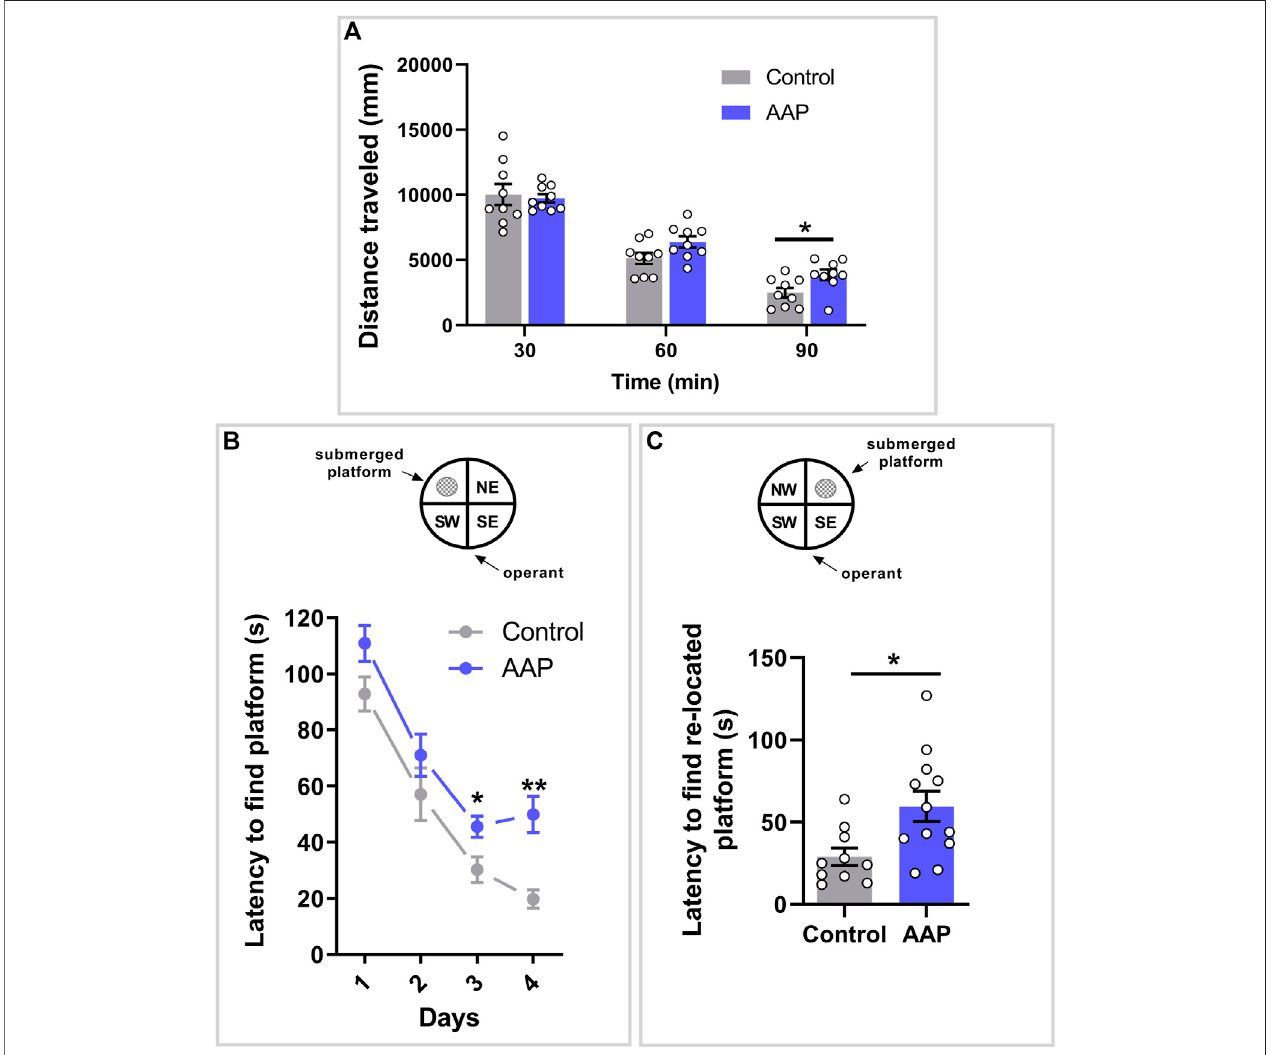
FIGURE 1 | Behavioral assessments in adulthood following neonatal exposure to AAP. (A) Spontaneous behavior in 3-month-old mice exposed to vehicle or AAP (30 + 30 mg/kg, 4 h apart) on PND 10. Distance traveled (mm) during each of the three time spells were measured when the mice were introduced to a new home cage ( n = 10). (B) Swim maze performance in four-month-old mice ( n = 10 – 12) exposed to vehicle or AAP (30 + 30 mg/kg, 4 h apart) on PND 10. Latencies (s) to locate the platform were measured during the 4 days acquisition period (trials 1 – 20) and (C) during re-learning period on the fi fth day (trials 21 – 25). Statistical differences are indicated as * if signi fi cantly different vs. controls p ≤ 0.05 and ** if signi fi cantly different vs. controls p ≤ 0.01. Bars represent means ± SEM.